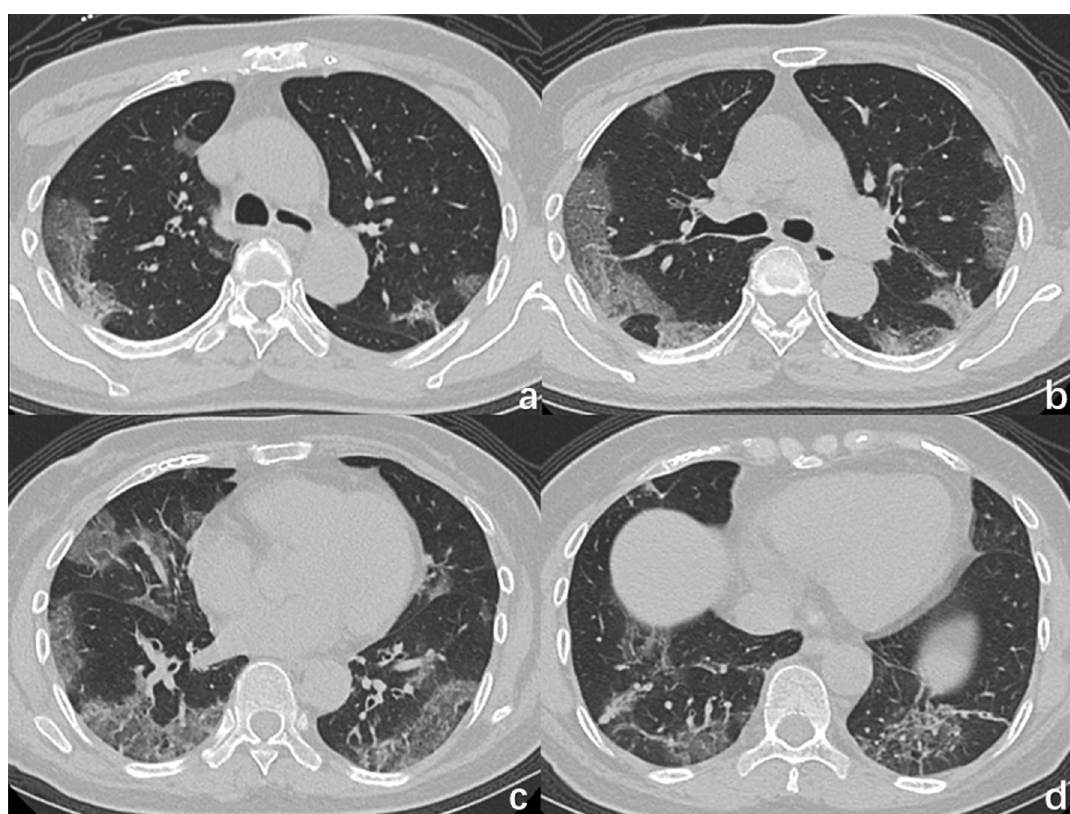
Figure 1. CT image of a 66-year-old man with COVID-19 infection, presenting fever with cough for 7 days, shows multiple GGOs in bilateral lung, mainly distributedin the subpleural areas, with reticular pattern (interlobular septal